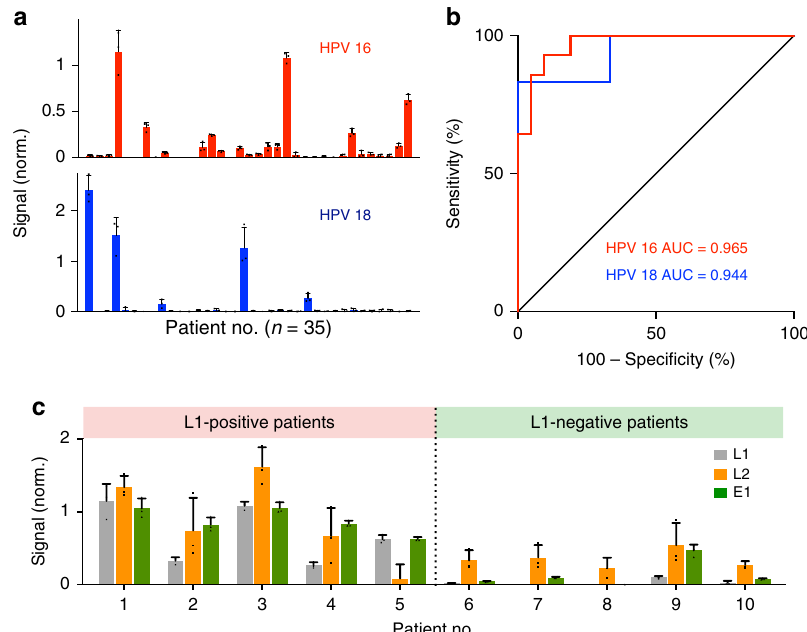
Fig. 5 Molecular pro fi ling of patient samples. a HPV 16 and HPV 18 signals were measured from clinical endocervical brush samples ( n = 35). The L1 - speci fi c signals are shown for comparison with the clinical gold standard. See Supplementary Fig. 14 for multi-loci measurements on all clinical specimens. b Receiver operator characteristic (ROC) curves of the HPV 16 and HPV 18 L1 locus assays were used to determine the detection accuracies. HPV 16